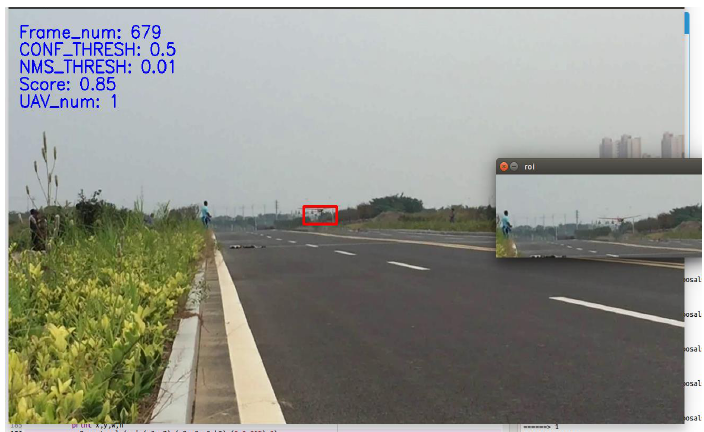
Figure 11. Setting Region of Interest (ROI) based on motion